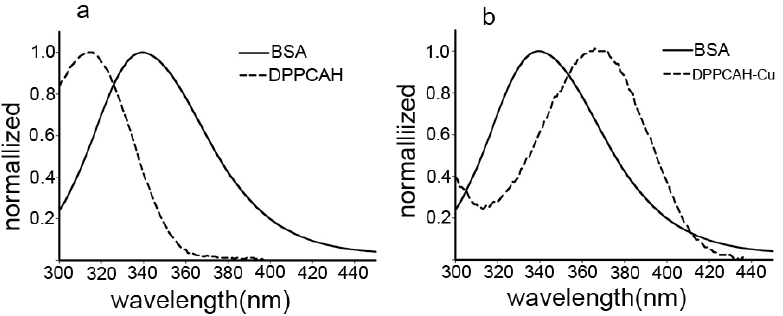
Figure 6. The overlap of the fluorescence spectra of BSA and the absorption spectra of ( a ) DPPCAH and ( b ) DPPCAH-Cu.